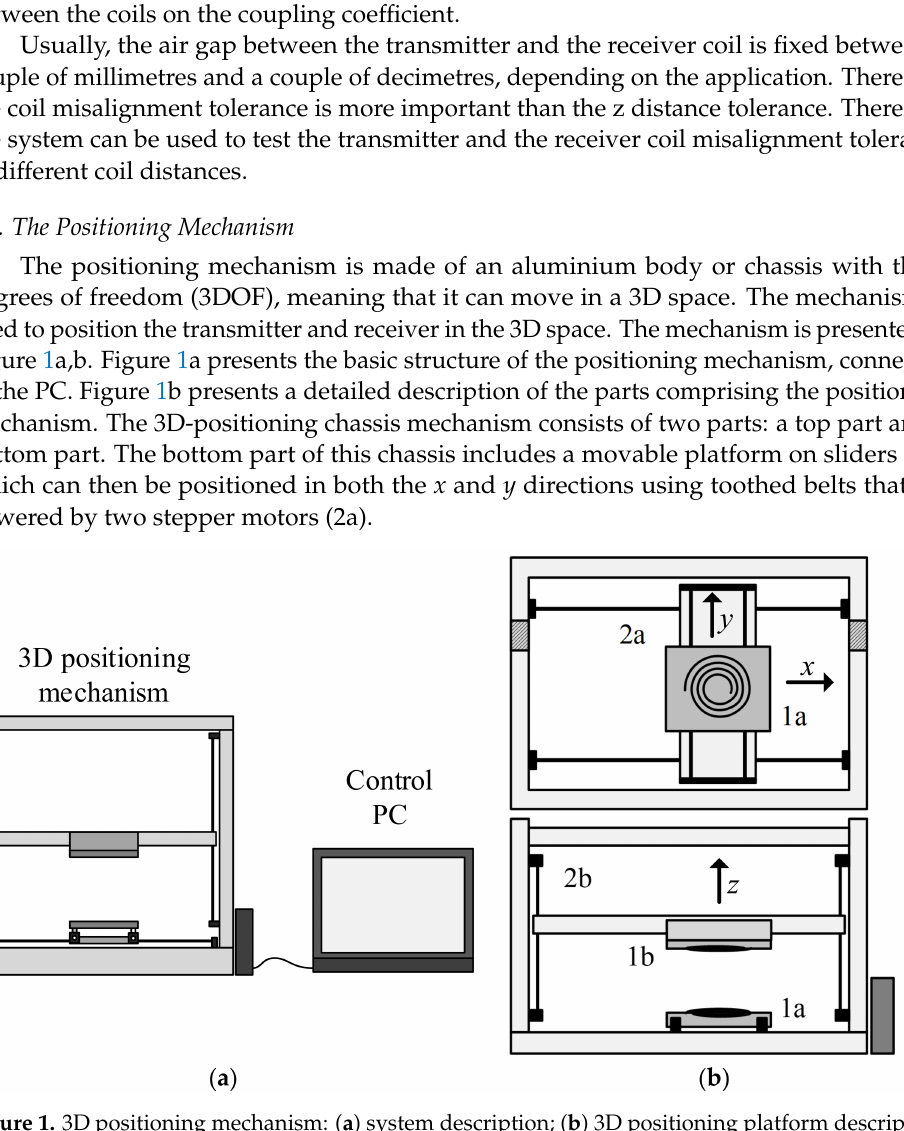
Figure 1. 3D positioning mechanism: ( a ) system description; ( b ) 3D positioning platform